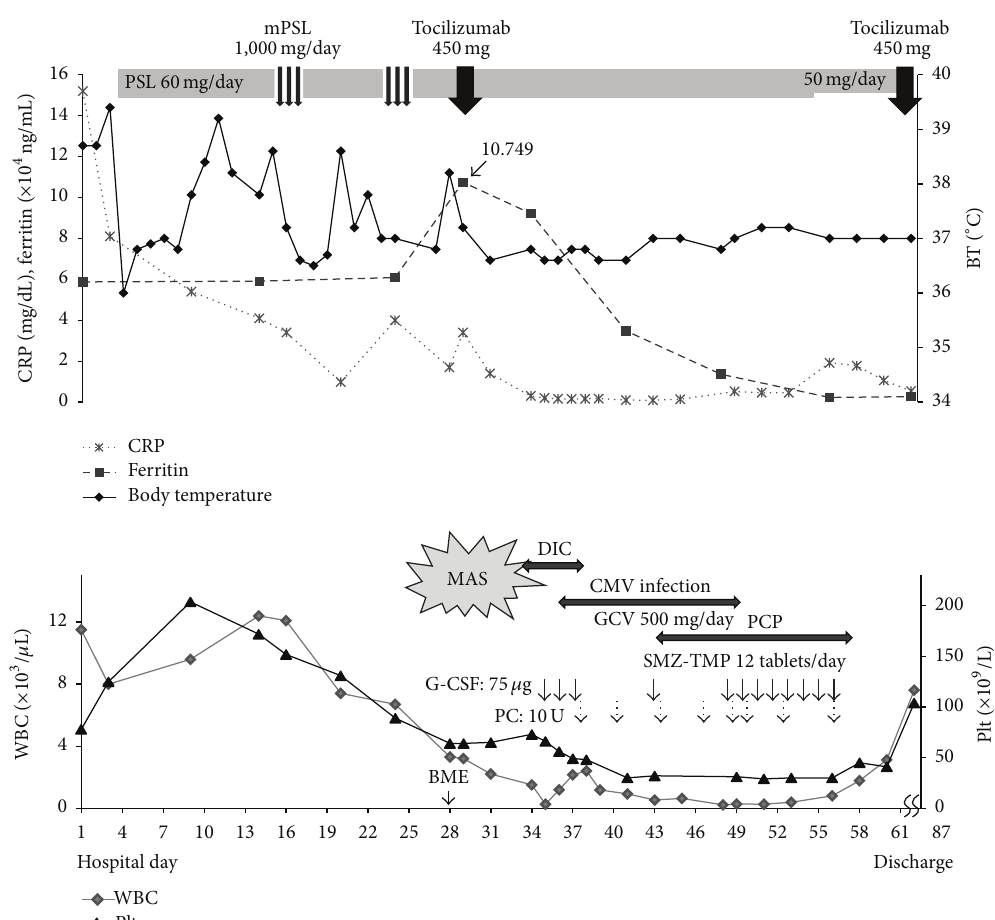
Figure 1: Clinical course during hospitalization. CRP, C-reactive protein; WBC, white blood cell; Plt, platelet; PSL, prednisolone; mPSL, methylprednisolone; PIPC/TAZ, piperacillin/tazobactam; CFPM, cefepime; MAS, macrophage activation syndrome; DIC, disseminated intravascular coagulation; CMV, cytomegalovirus; GCV, ganciclovir; PCP, Pneumocystis jirovecii pneumonia; SMZ-TMP, sulfamethoxa- zole/trimethoprim; G-CSF, granulocyte colony-stimulating factor; PC, platelet concentrate; BME, bone marrow